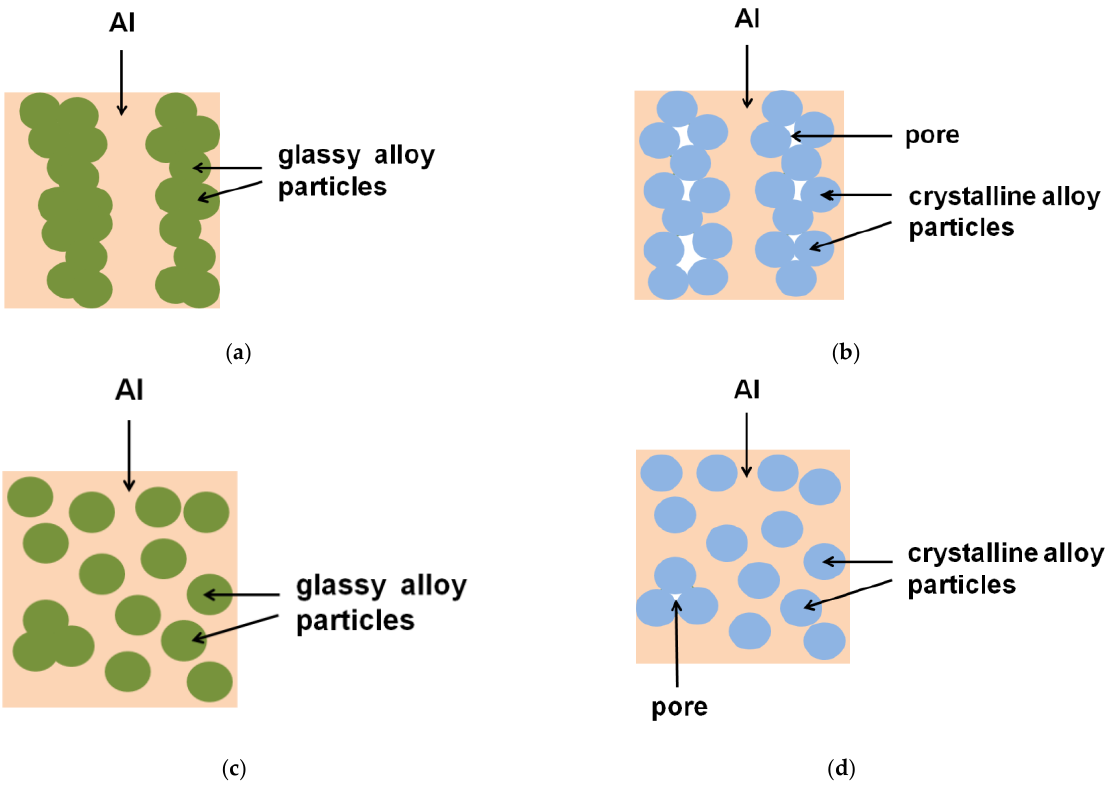
Figure 9. Schematic of the microstructures of aluminum matrix composites formed using a glassy ( a , c ) or a crystalline ( b , d ) alloy reinforcement. or a crystalline ( b , d ) alloy